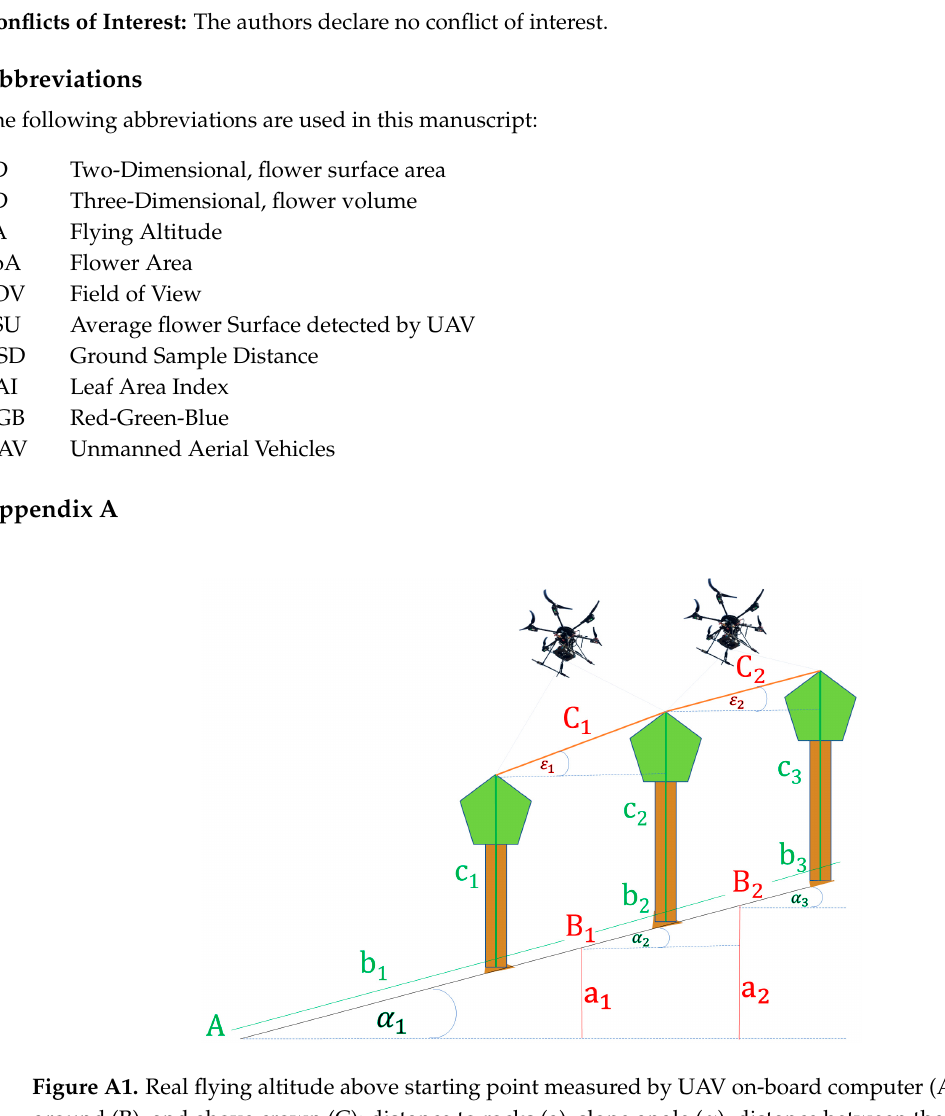
Scale bars were placed on the ground in the forest stand (Vertical and Horizontal Analysis). When calculating the flower area, the scale bar should be adapted to the crowns, where the flowers are located. Therefore, the FA above the crowns (C) is calculated from the FA above the ground (B) minus the tree heights (c):